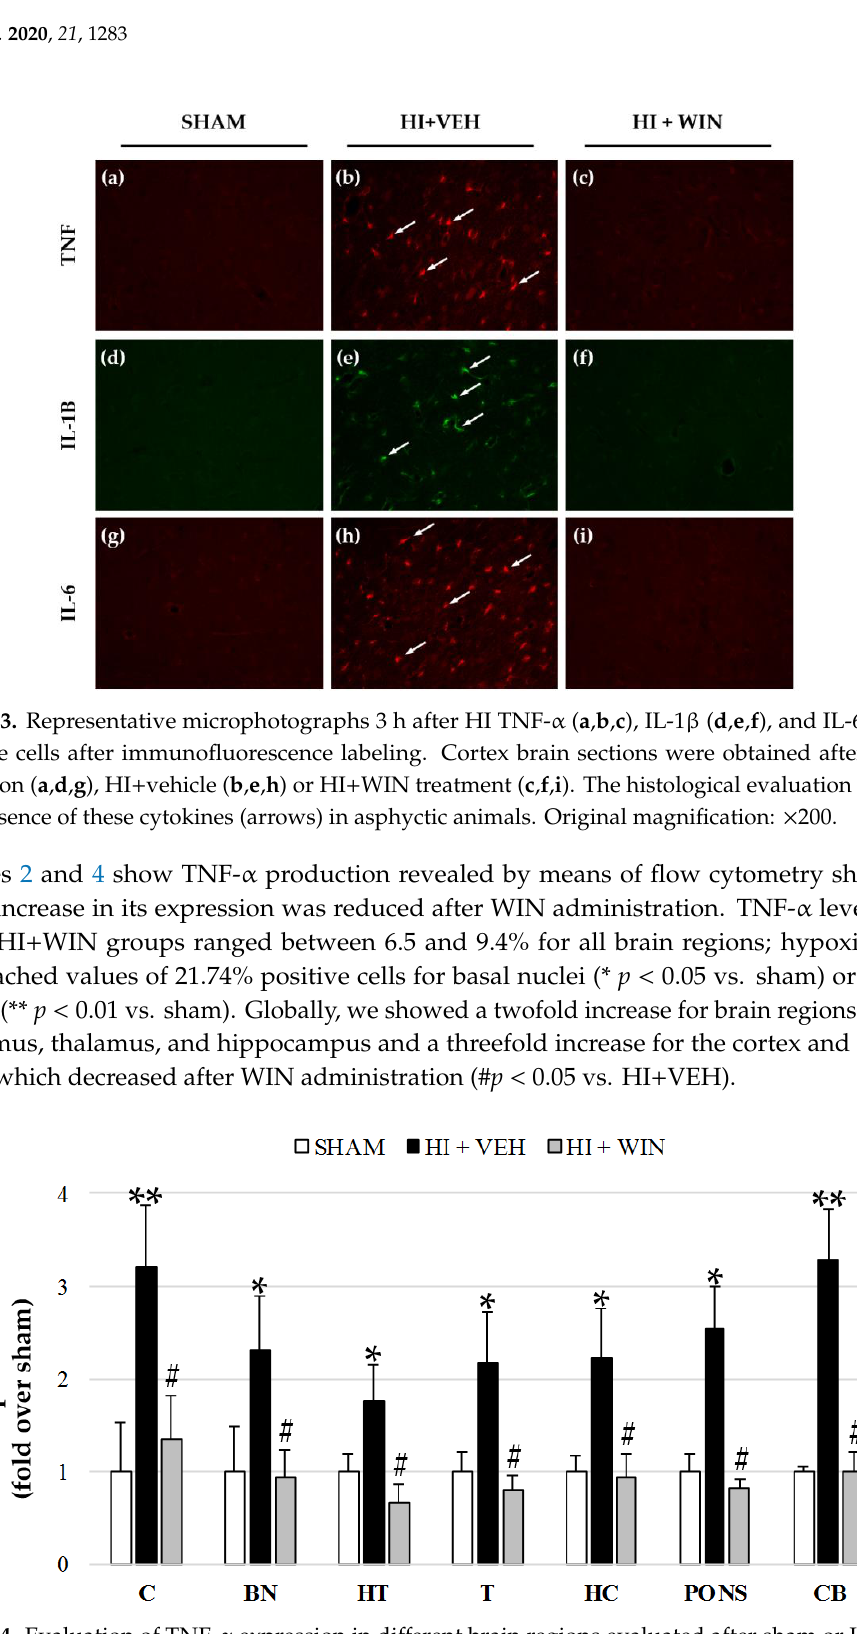
Figure 4. Evaluation of TNF- α expression in di ff erent brain regions evaluated after sham or HI (and vehicle or WIN treatment) in fetal lambs. Samples from both hemispheres were analyzed in triplicate by flow cytometry ( n = 6) for each animal and condition. Values given as the mean ± SD of the percentage of TNF- α positive cells. (*) ANOVA p < 0.05 vs. sham and HI + WIN; (**) ANOVA p < 0.01 vs. sham and HI + WIN; (#) ANOVA p < 0.05 vs. HI + VEH. Sham, n = 6; HI + VEH, n = 6; HI + WIN, n = 6. (C: cortex; BN: basal nuclei; HT: hypothalamus; T: thalamus; HC: hippocampus; CB: